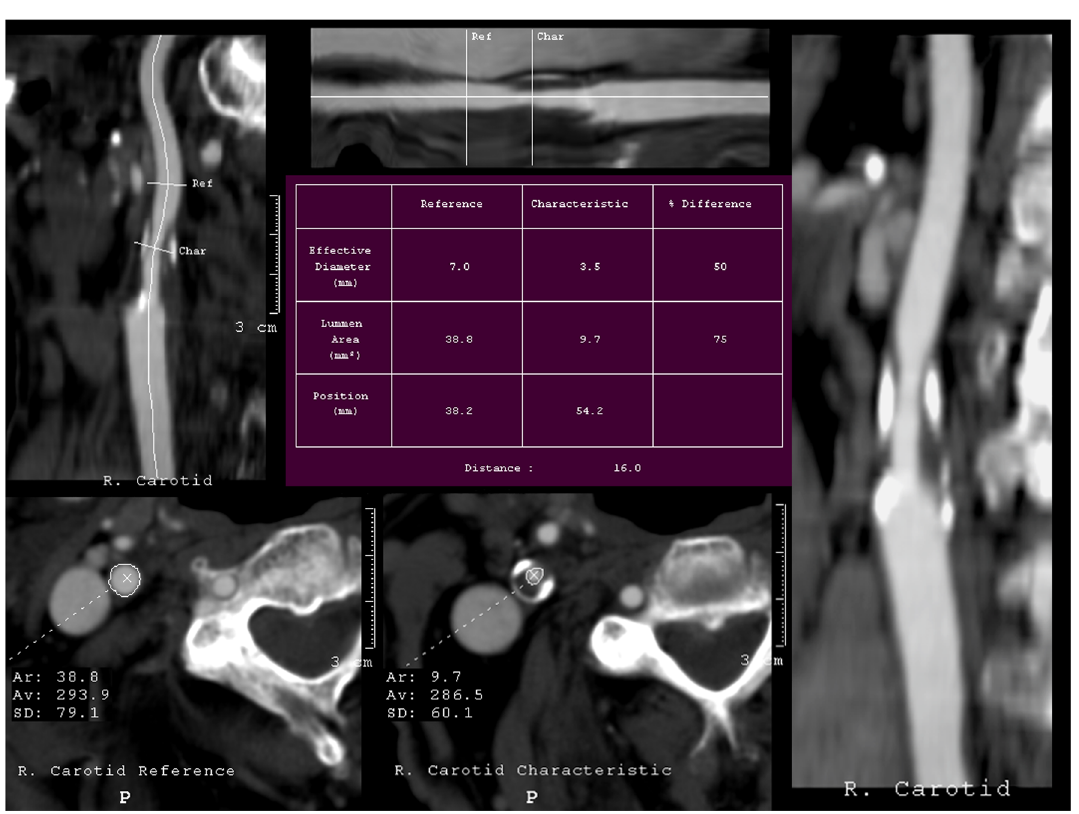
Fig. 1 Automated quantification of an eccentric right carotid artery stenosis on CTA. Percentage of stenosis is calculated by electronically outlining the residual and the normal vessel lumen in a plane perpendicular to the longitudinal axis of the vessel. In this example, the